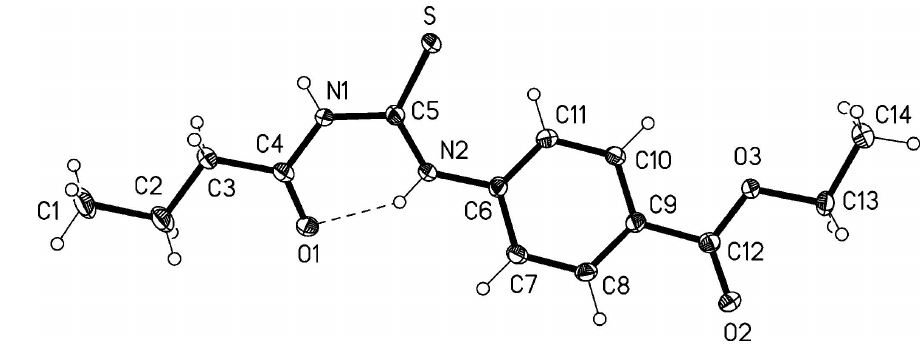
Figure 1 The molecular structure of the title compound in the crystal. Ellipsoids represent 50% probability levels.